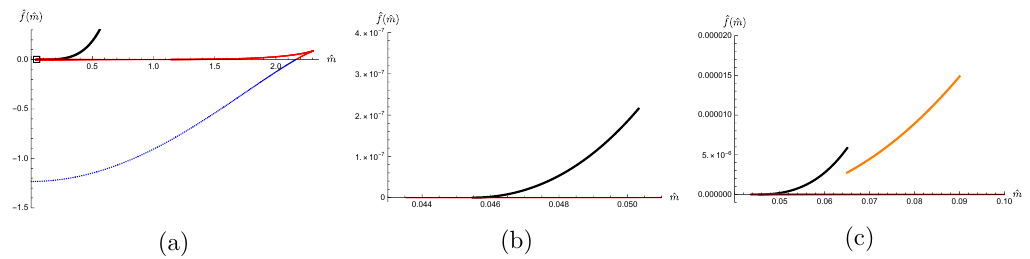
Figure 4. a) Dimensionless free energy density ˆ f as a function of ˆ m for a choice of parameters √ N 3 such that = 45 and N 3 = 0 . 1 for the solution of section 3 (black branch) and the numerical N 5 N solution (red and blue branches) of [12]. The rectangle captures the perturbative regime (4.21). (b) Zooming in the rectangle of figure (a). There exists a branch of solutions which start life close to the supersymmetric point of [12]. (c) Plot of ˆ f where now we also include the unstable branch of the blackfold solution (orange curve), for the same choice of parameters as in 4(a),